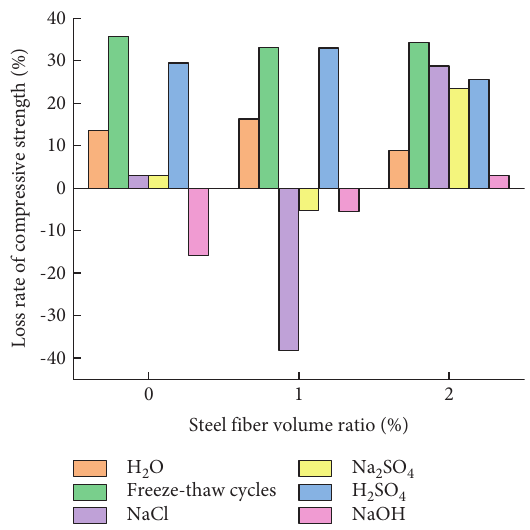
Figure 18: Loss rate of compressive strength